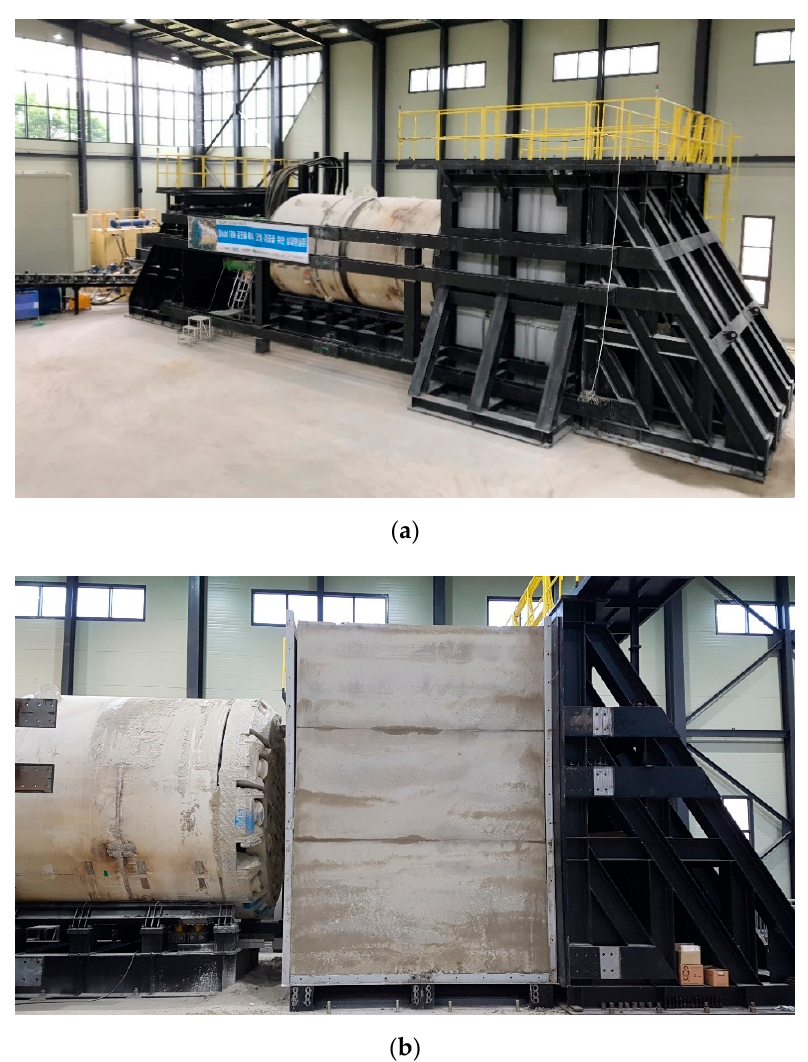
Figure 1. An earth pressure balance (EPB) shield TBM and test facilities for full-scale tunneling tests, ( a ) TBM assembly in the test facility; ( b ) Side view of the rock box having artificially developed rock mass.